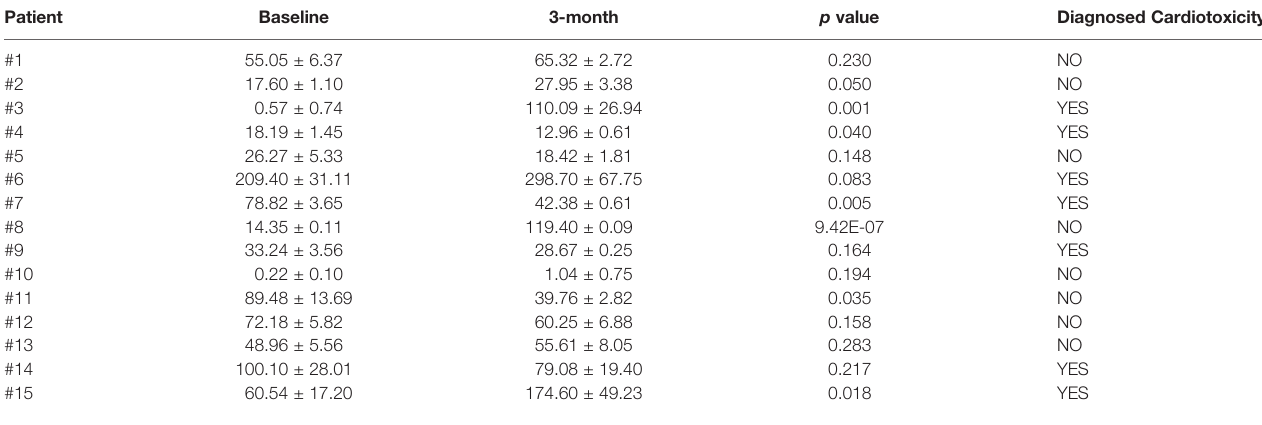
TABLE 2 | Comparisons of plasma cMLC-1 levels before and 3-month after trastuzumab treatment in BC patients. Patient